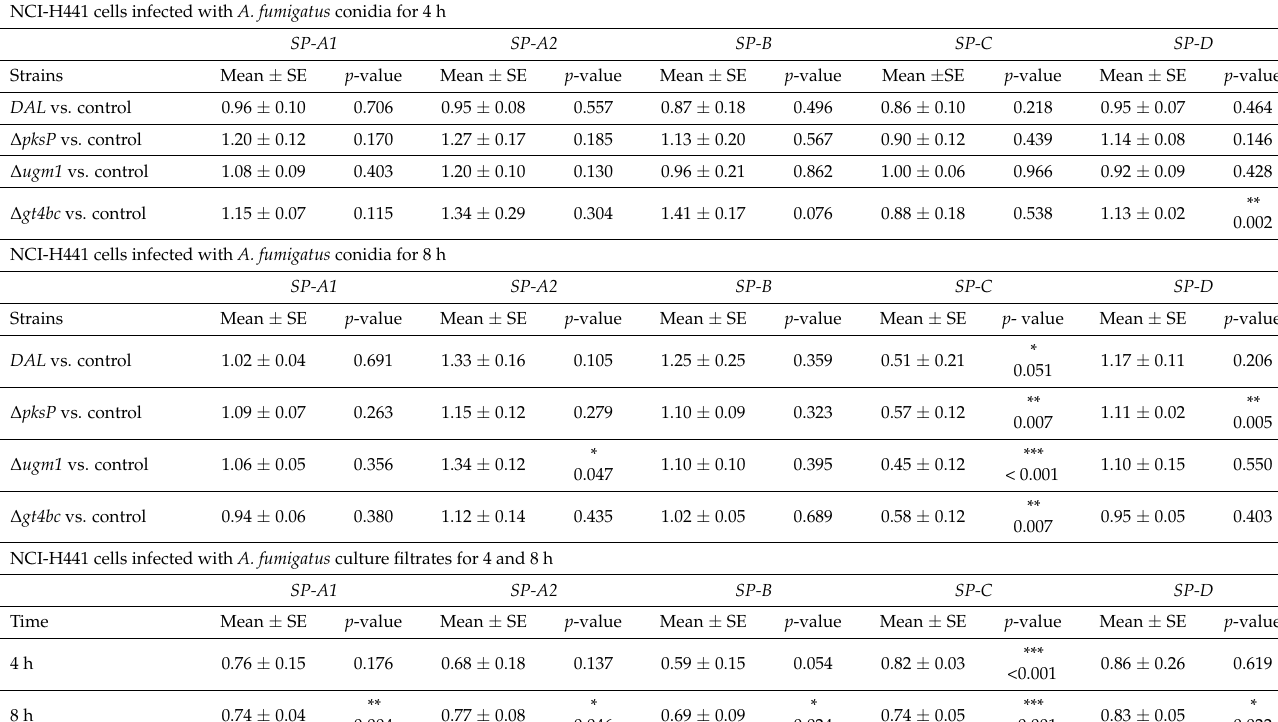
Figure 2. Relative fold change of the mRNA expression levels of SP-A1 , SP-A2 , SP-B , SP-C and SP–D . All data are normalized with RPLP0 rRNA expression and given as relative to untreated control. Cells were treated with swollen conidia obtained from A.fumigatus strains for 4 h ( a ) and 8 h ( b ). Columns depict mean ± SE of the mean (* p ≤ 0.05), (** p ≤ 0.01), (*** p ≤ 0.001). See also Table 1. Table 1. Statistical analysis of RT-qPCR data.